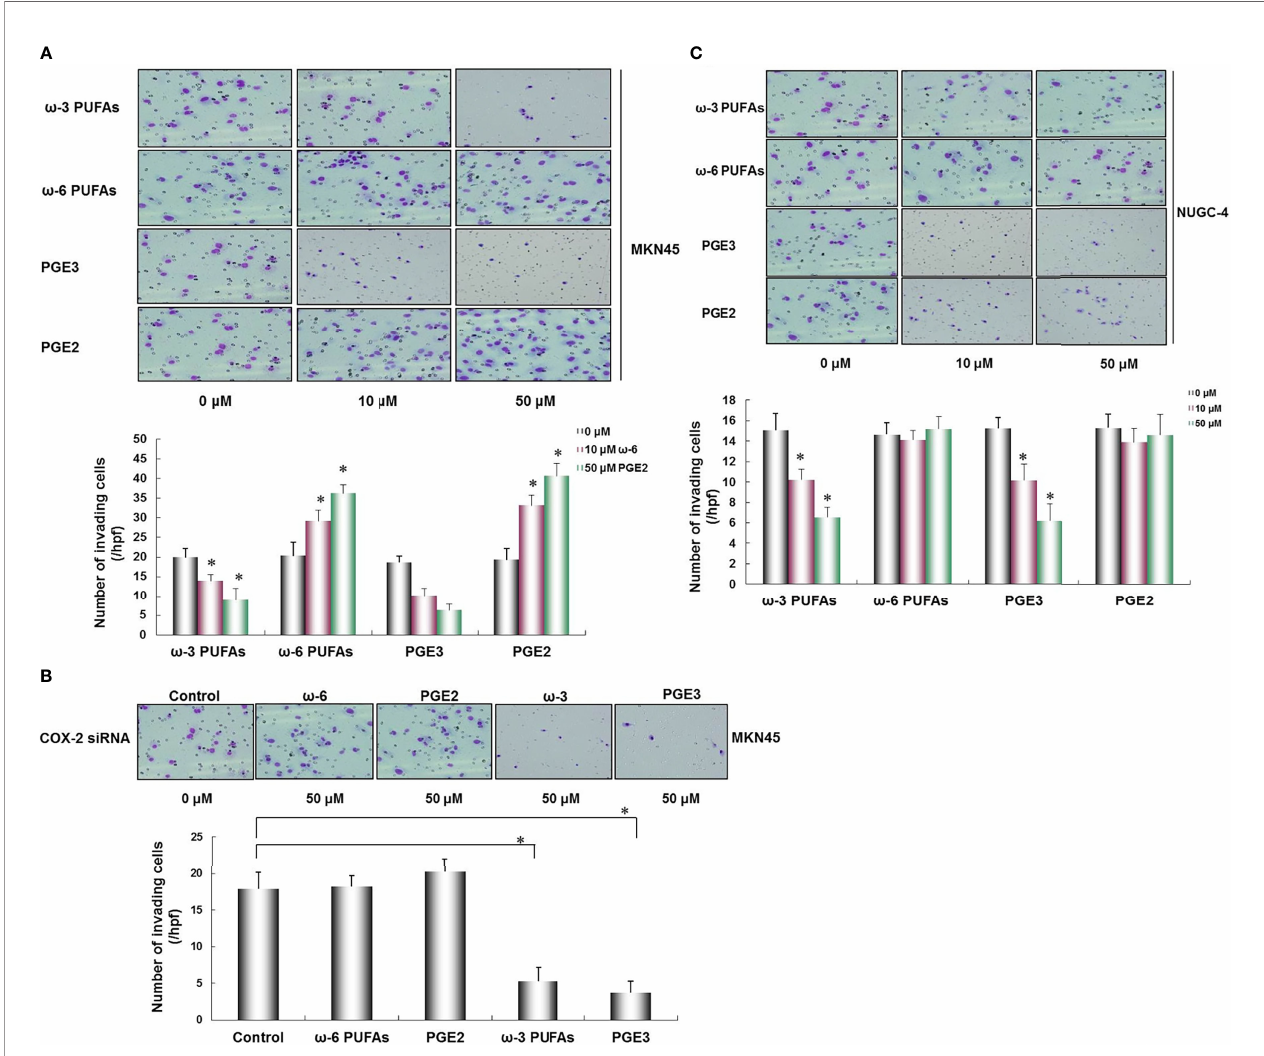
FIGURE 5 | Effects of w -3 PUFAs, w -6 PUFAs, PGE2, and PGE3 on gastric cancer cell invasion. PGE3 and w -3 inhibited the invasion of MKN45 cells, and as for w - 6 and PGE2, there was no signi fi cant effect on the invasive ability of MKN45 cells (A) . In the MKN45 cells transfected with COX-2 siRNA, no signi fi cant changes were found in the presence of w -6 and PEG2 in MKN45 cells. PGE3 and w -3 could signi fi cantly reduce the invasion capability of MKN45 cells compared with the control (B) . The invasion of NUGC-4 cells was inhibited by w -3 and PGE2 in a concentration-dependent manner compared with the control (* p < 0.01) and w -6 and PGE2 cannot signi fi cantly in fl uence the invasiveness of NUGC-4 cells (C) . Multiple comparisons used the method of one-way ANOVA followed by the SNK test. Columns, relative invading number. Bars indicate SD, * p < 0.01. The experiment was carried out in